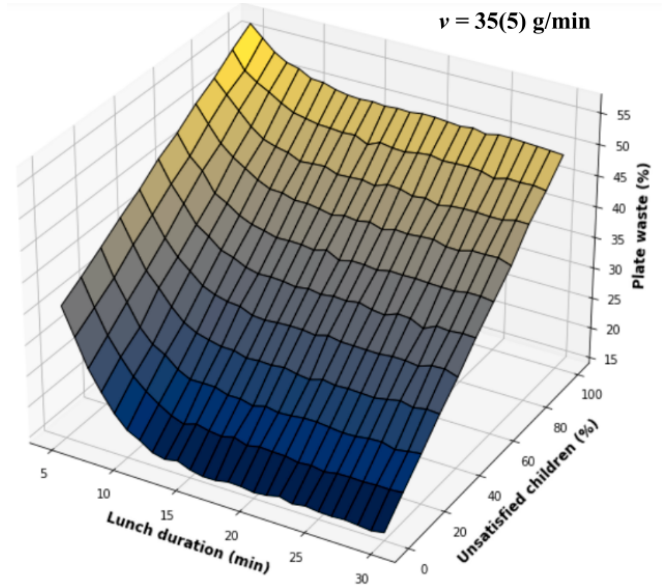
Figure 8. Simulation results.